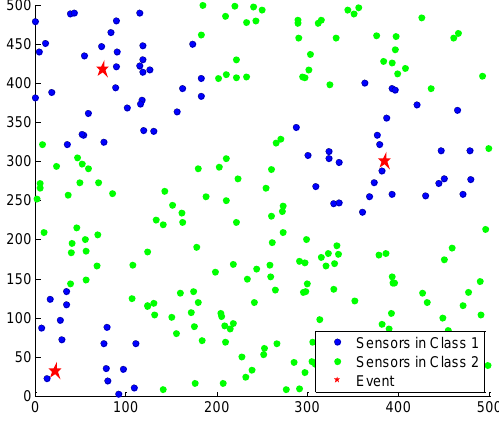
Figure 13. The random sensor network with three events (denoted by red stars) and two windows. The sensors in the first window are denoted by blue circles, and the other sensors are denoted by green nodes.